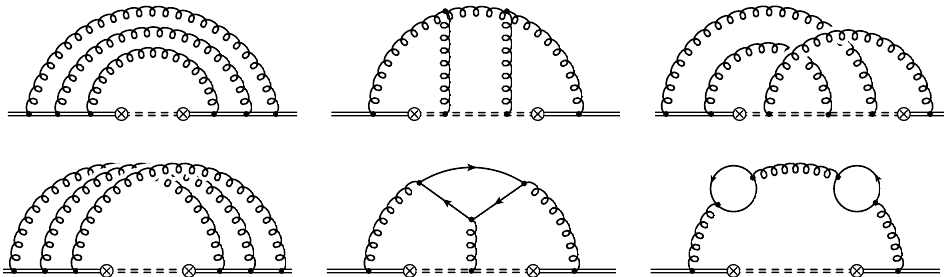
Figure 2 . Sample Feynman diagrams contributing to S hl at N 3 LO. Time-like Wilson lines, light- like Wilson lines, gluons, and light fermions are represented by solid double lines, dashed double lines, curly lines, and solid lines, respectively. The direction of the Wilson lines and the prescription for the routing of the external momentum ! are the same as in the one-loop diagram on the right of (cid:12)gure